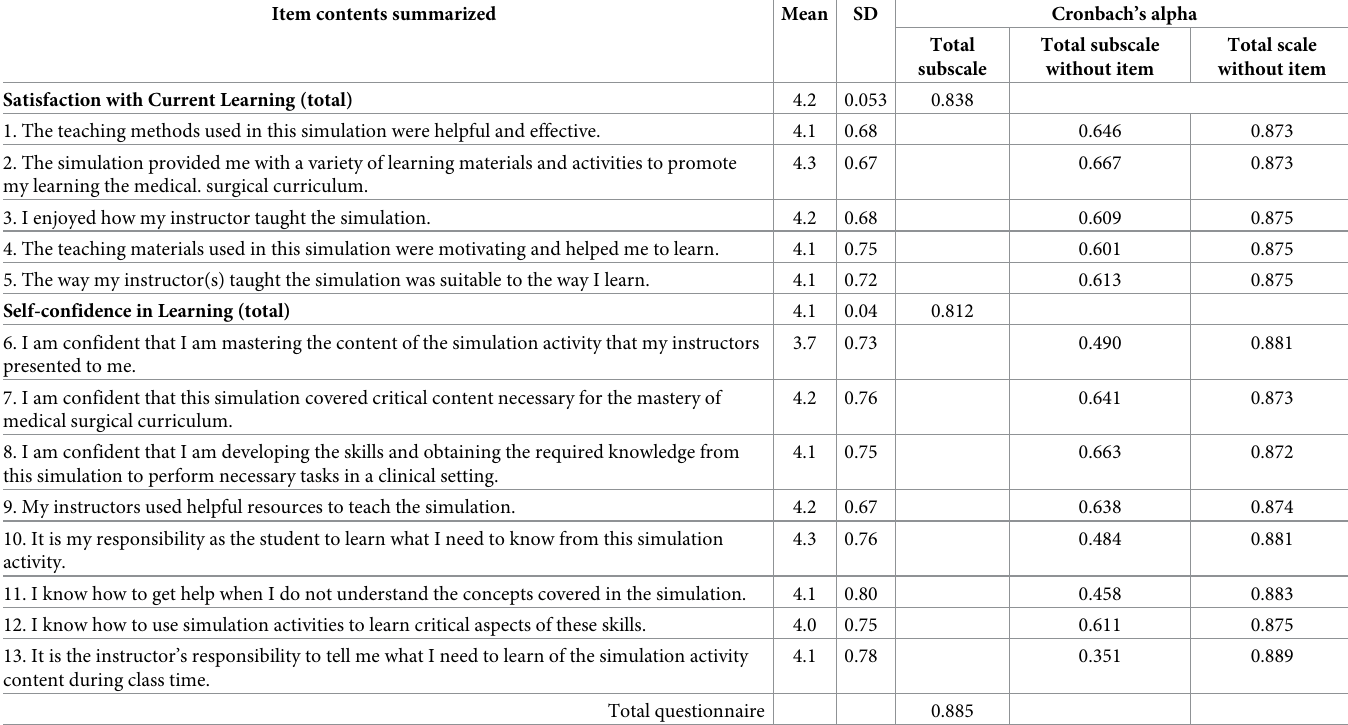
Table 3. Internal consistency coefficient (Cronbach’s alpha) for the student satisfaction and self-confidence in learning